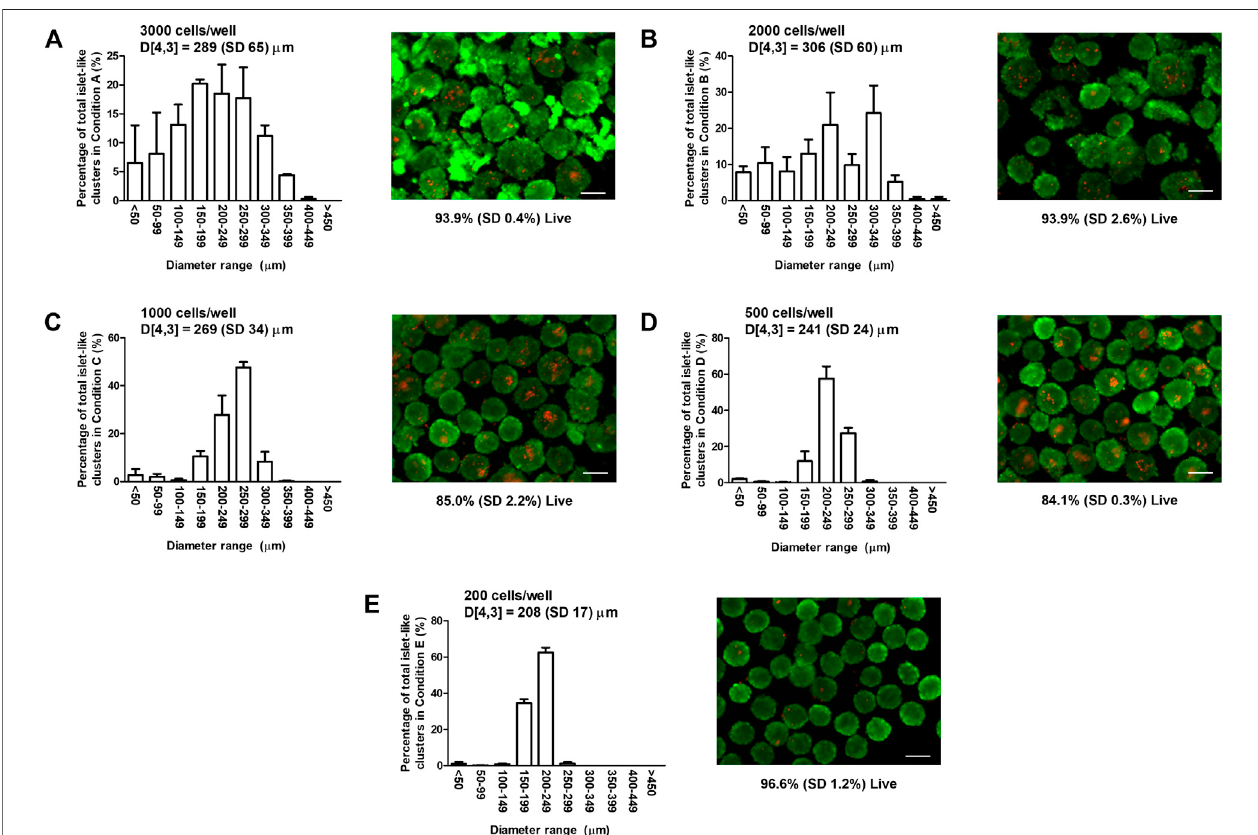
FIGURE 1 | Mouse insulinoma 6 (MIN6) aggregate size distribution and viability. Bar graphs show the size distribution and volume mean moment (De Brouckere mean diameter) D [4,3] with standard deviation SD of MIN6 islet-like clusters (ILCs) generated using AggreWell ™ 400 microwell plates. Fluorescence images show representative live/dead staining results using calcein-AM (green) and ethidium homodimer-1 (red), from which the mean percentage of live cells is determined. (A) Seedingdensity=3,000cells/well,D[4,3]=289(SD65)µm,viability=93.9%(SD0.4%); (B) Seedingdensity=2,000cells/well,D[4,3]=306(SD60)µm,viability= 93.9% (SD 2.6%); (C) Seeding density = 1,000 cells/well, D [4,3] = 269 (SD 34) µm, viability = 85.0% (SD 2.2%); (D) Seeding density = 500 cells/well, D [4,3] = 241 (SD 24) µm, viability = 84.1% (SD 0.3%); and (E) Seeding density = 200 cells/well, D [4,3] = 208 (SD 17) µm, viability = 96.6% (SD 1.2%). N = 3 biological replicates with 30 images ( > 400 ILCs) analyzed per condition. Error bars represent the standard deviation. Viability results were analyzed using a one-way analysis of variance and Tukey multiple comparisons post-hoc test. Conditions (C,D) were signi fi cantly different from Conditions (A,B,E) ( p < 0.001). All other combinations were not signi fi cantly different ( p > 0.05). Scale bar = 200